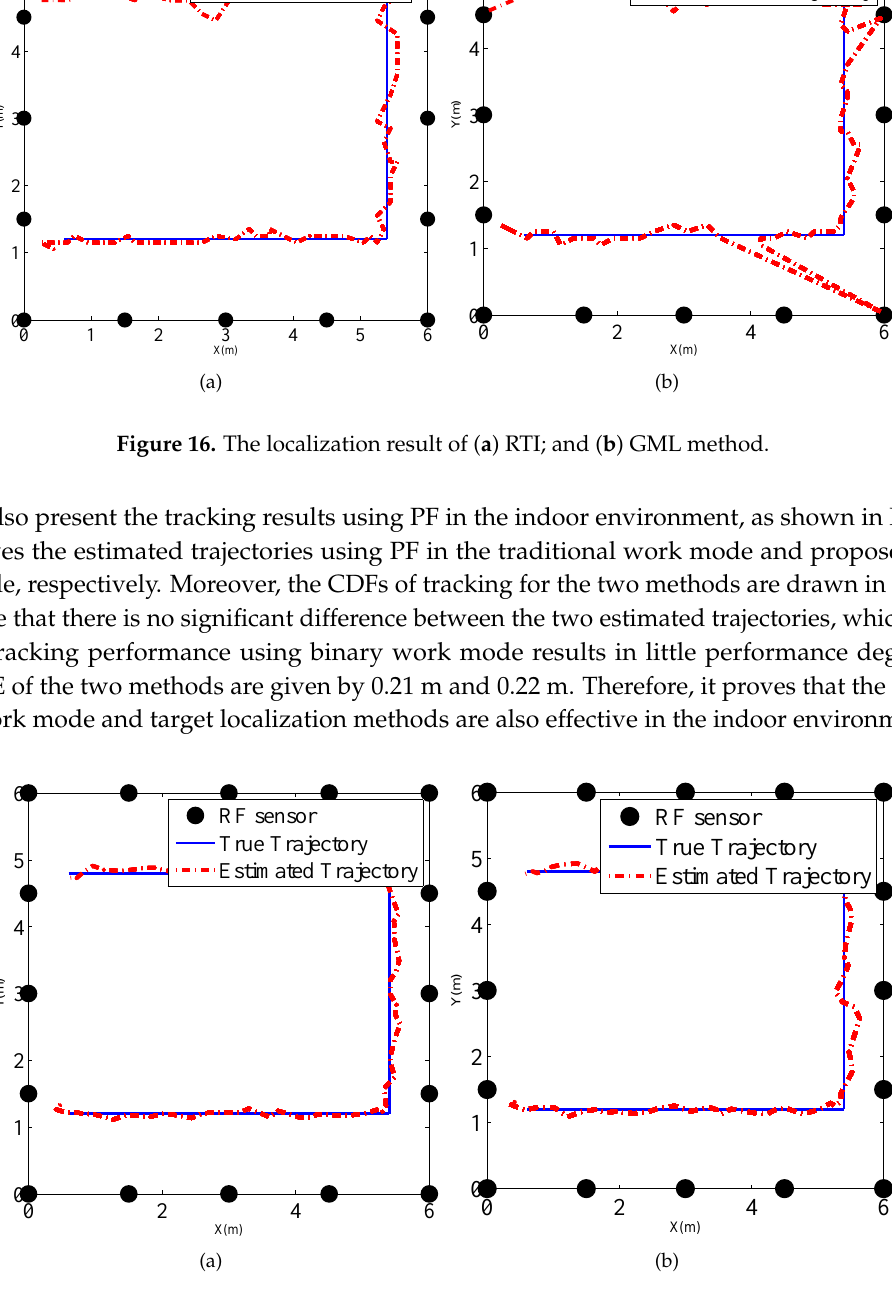
Figure 17. Tracking result of ( a ) traditional mode using raw measurements; and ( b ) binary mode using link states in the outdoor